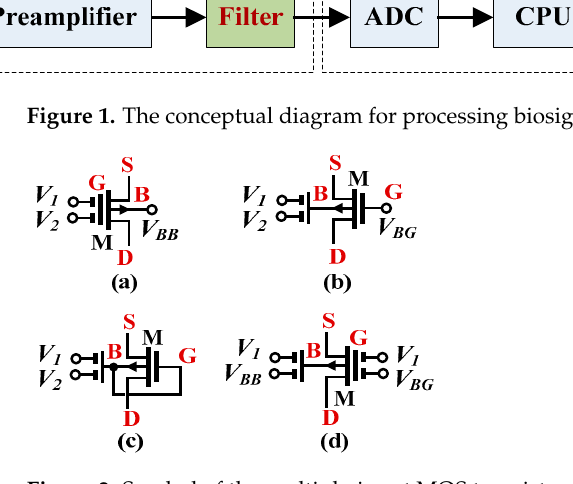
Figure 2. Symbol of the multiple-input MOS transistor: gate ( a ), bulk ( b ), DTMOS ( c ) and QFG ( d ). The realization of the multiple-input with bulk-driven MOS device is shown in Fig- ure 3. The multiple-input is constructed by a capacitive summing circuit using capacitors C i ( i = 1,…,N) connected to the bulk terminal of a MOS transistor. To provide proper bias- ing of the bulk terminal for DC operation, the high resistance resistors R MOS is used. These R MOS are realized as the anti-parallel connection of two minimum-size transistors M L , op- erating with V GS = 0. For AC signals, and for frequencies f >> 1/2 π C i R MOSi , i = 1…N, resistors R MOS are shunted by capacitances C i , which create an analog voltage divider/voltage sum- ming circuit, with the gain coefficients determined solely by the ratio of capacitances [15].